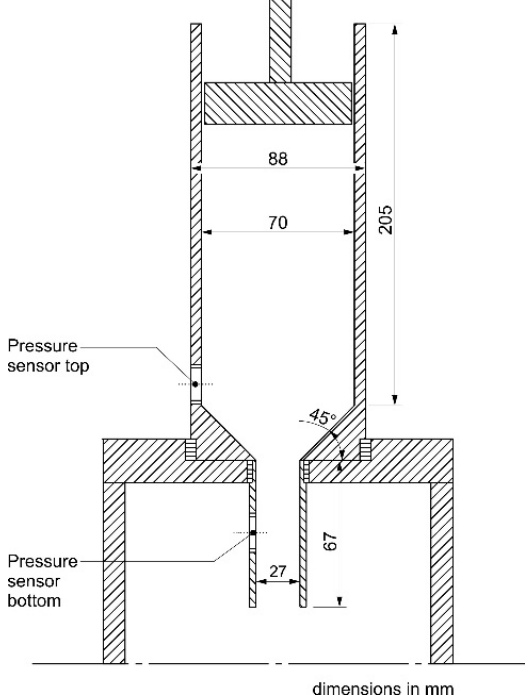
Figure 6. Sketch and dimensioning of the capillary rheometer test set-up based on [8].